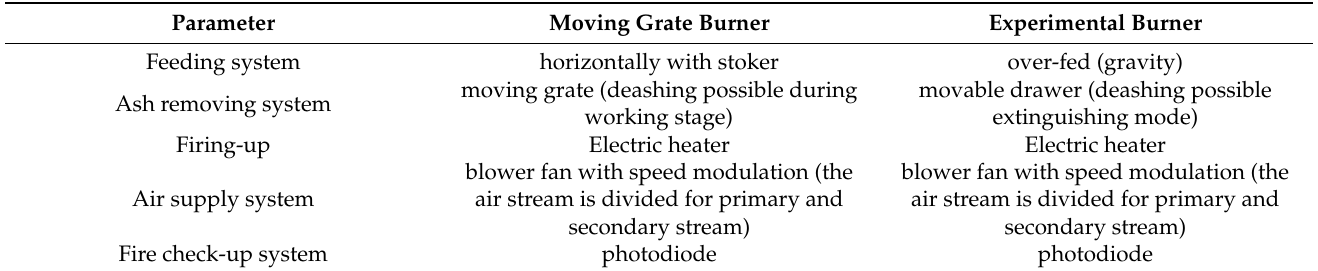
Figure 2. A 16 kW experimental overfed burner which was used for testing [52]. Table 1. Comparison of the technical specifications of tested pellet burners. Table 1. Comparison of the technical specifications of tested pellet